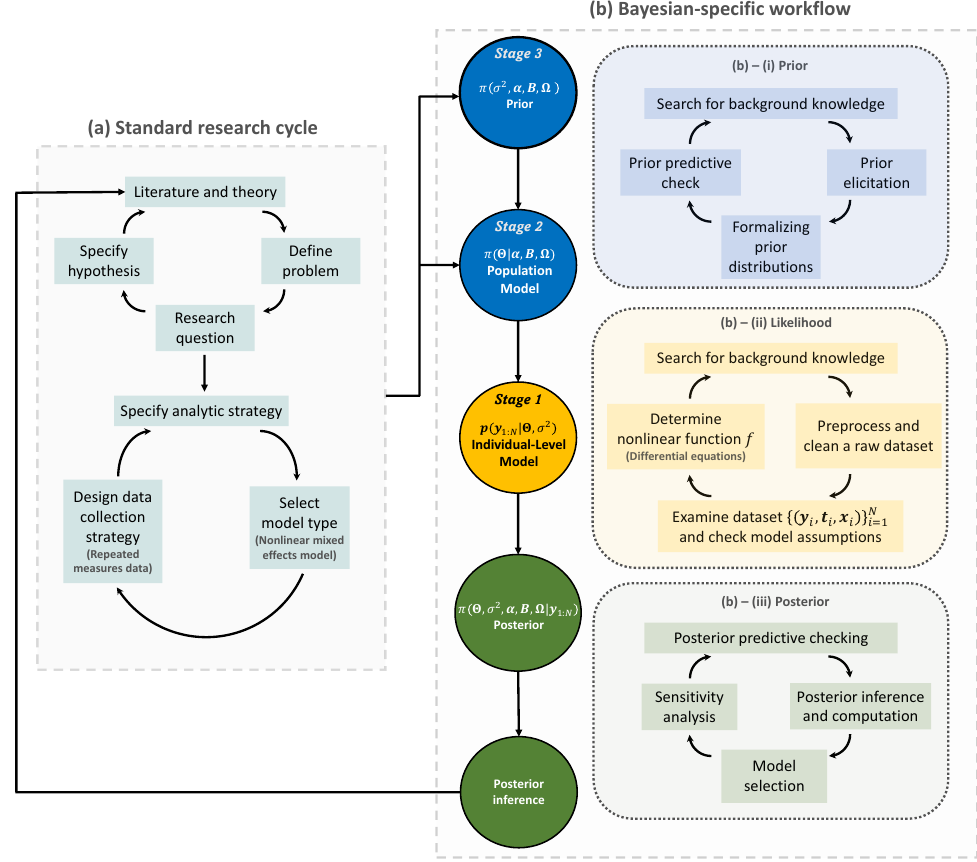
Figure 2. The Bayesian research cycle. A research cycle using Bayesian nonlinear mixed effects model comprises two steps: ( a ) standard research cycle and ( b ) Bayesian-specific workflow. Standard research cycle involves literature review, defining a problem and specifying the research question and hypothesis. Bayesian-specific workflow comprises three sub-steps: (b)–(i) formalizing prior distributions based on background knowledge and prior elicitation; (b)–(ii) determining the likelihood function based on a nonlinear function f ; and (b)–(iii) making a posterior inference. The resulting posterior inference can be used to start a new research cycle. Distributions for prior, likelihood, and posterior are colored in blue, yellow, and green, respectively. Θ , model matrix; σ 2 , error variance parameter; α , intercepts; B , coefficient matrix; Ω , covariance matrix; p ( . ) , probability distribution; π ( . ) , prior or posterior probability distribution; { ( y i , t i , x i ) } N , i = 1